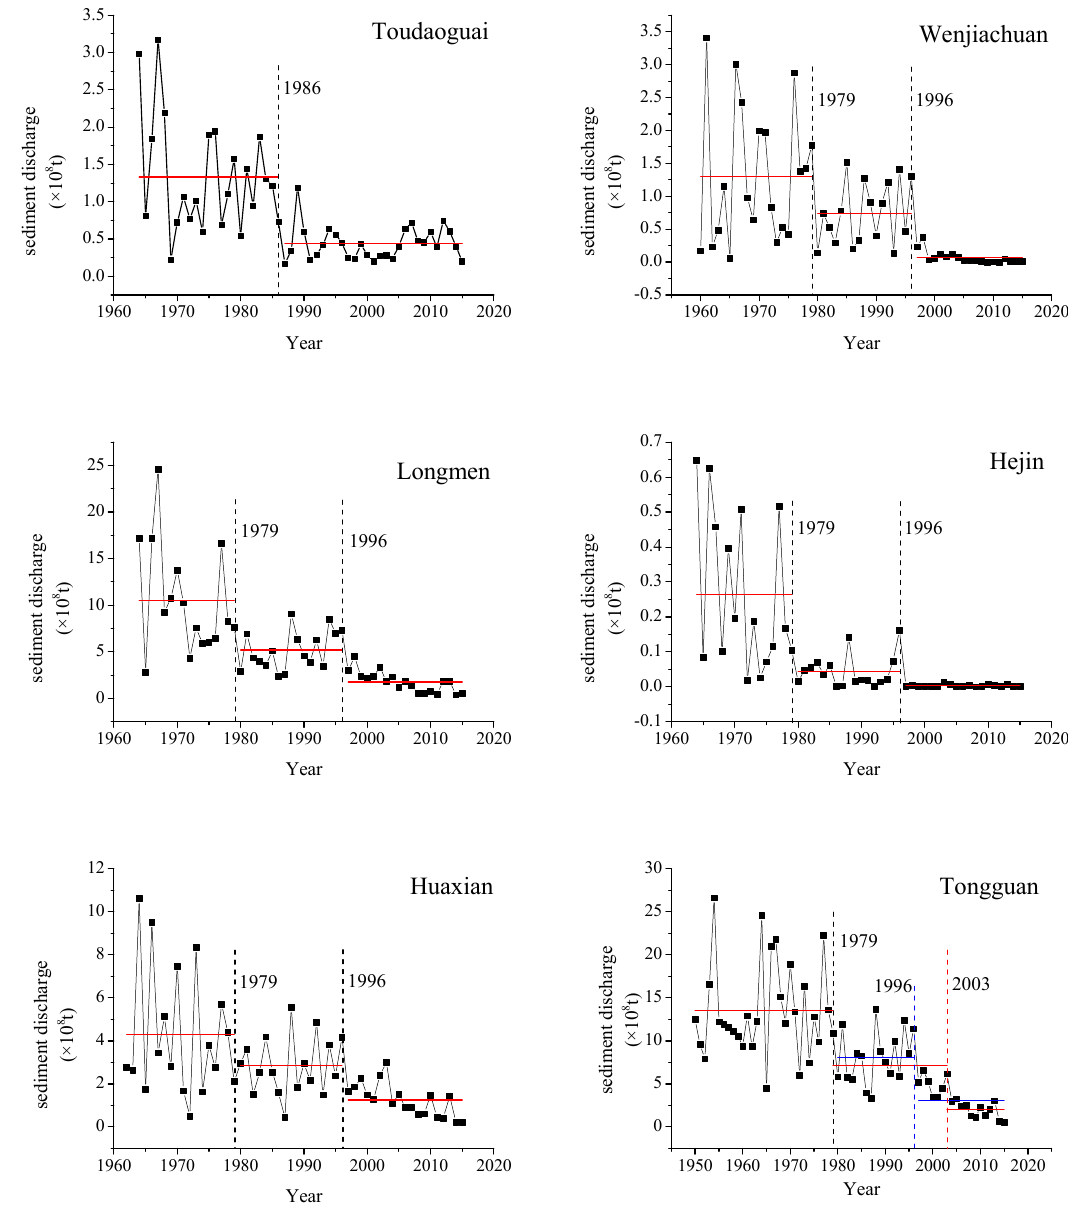
Figure 10. Abrupt change analysis for annual sediment discharge of six hydrological stations.